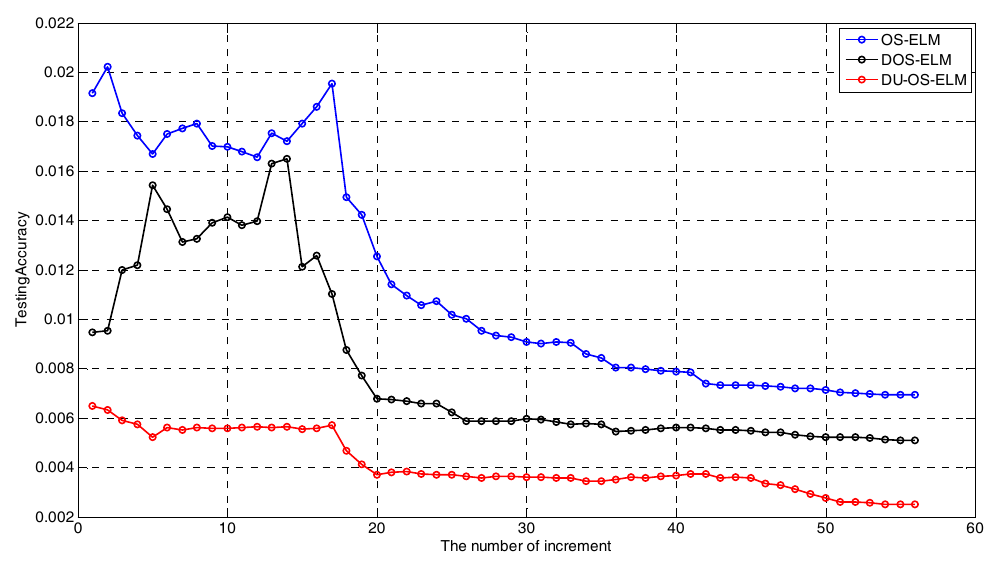
Figure 7. Selection of step size µ .